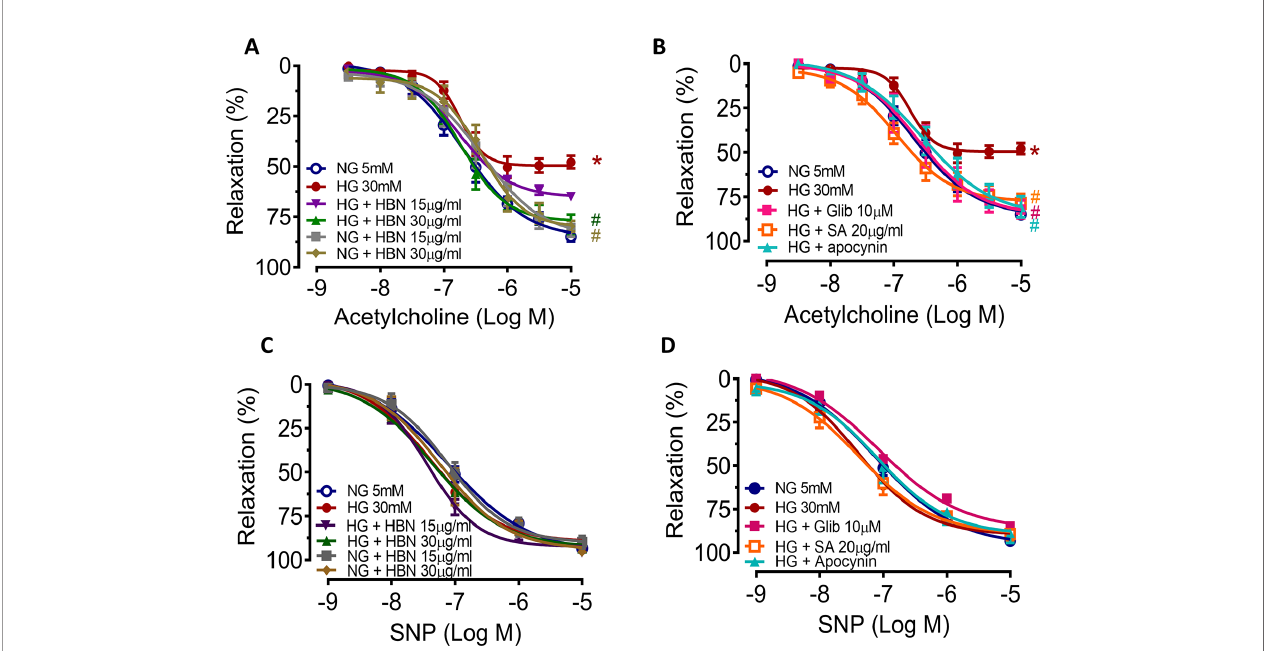
FIGURE 2 | The effect of isolated aorta from C57BL/6J treated with normal glucose (NG, 5 mM), high glucose (HG, 30 mM), hydrolyzed bird nest (HBN, 15 and 30 m g/mL), sialic acid (SA, 20 m g/mL), glibenclamide (Glib, 10 m M), and apocynin (20 m M) for 48 h in acetylcholine-induced endothelium-dependent relaxation (EDR) (A, B) and sodium nitroprusside-induced endothelium-independent relaxation (EIR) (C, D) . Results are means ± SEM of six experiments. *P < 0.05 compared with NG, # P < 0.05 when compared with